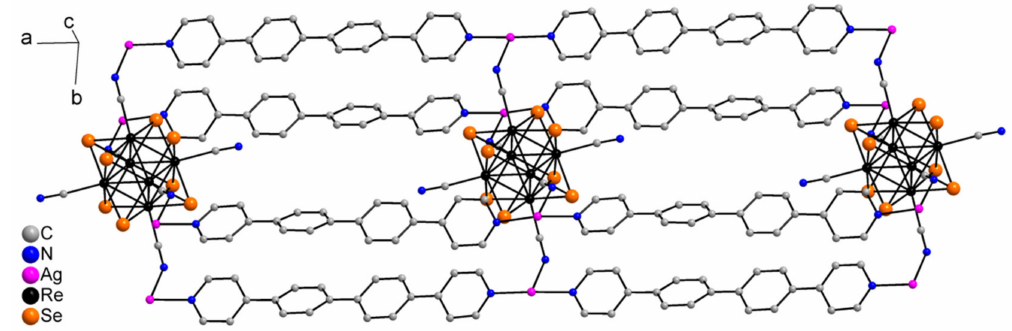
Figure 17. 1D fragment of compound 5 .